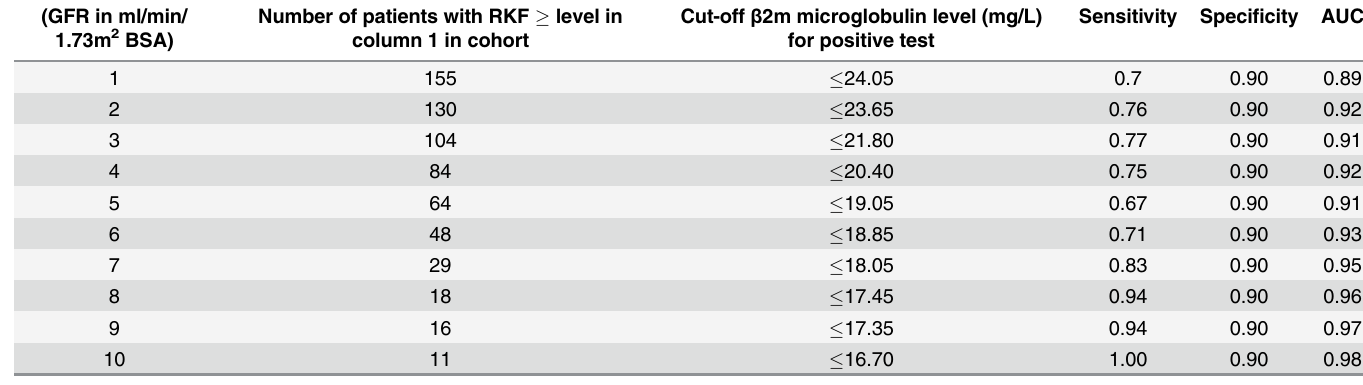
Table 6. B2-microglobulin level cut-off levels that may be used to identify patients with residual renal function measured as GFR. For various levels of GFR the cut-off β 2 microglobulin level was determined that would yield a false positive rate (specificity) of 10%. For each GFR level area under the curve is shown for ROC